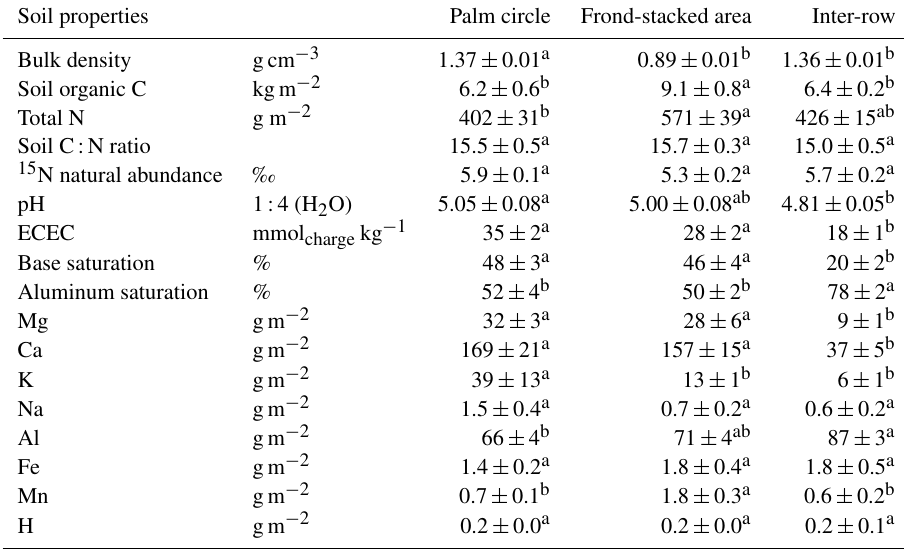
Table 1. Soil physical and biochemical characteristics (mean ± standard errors, n = 4 plots) in the top 50cm depth for each management zone, averaged across experimental treatments. Means within a row followed by different letters indicate significant differences among management zones (one-way ANOVA with the Tukey HSD or Kruskal–Wallis H test with multiple comparison extensions at P ≤ 0 . 05). Bulk density measured in the top 10cm of soil, whereas all the other parameters are for 0–50cm soil depth: element stocks are the sum of the sampled soil depths (0–5, 5–10, 10–30 and 30–50cm) and the rest are depth-weighted averages, calculated for each replicate plot. ECEC, effective cation exchange capacity.